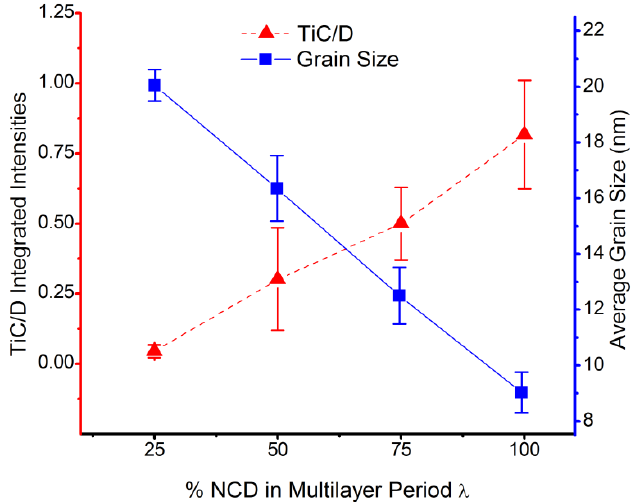
Figure 4. TiC/D ratio and average diamond grain size for multilayered coatings with varying percentage of NCD in multilayer period